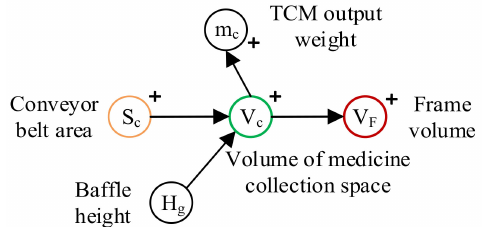
Figure 17. Physical parameter change path of “Unable to dispense TCM